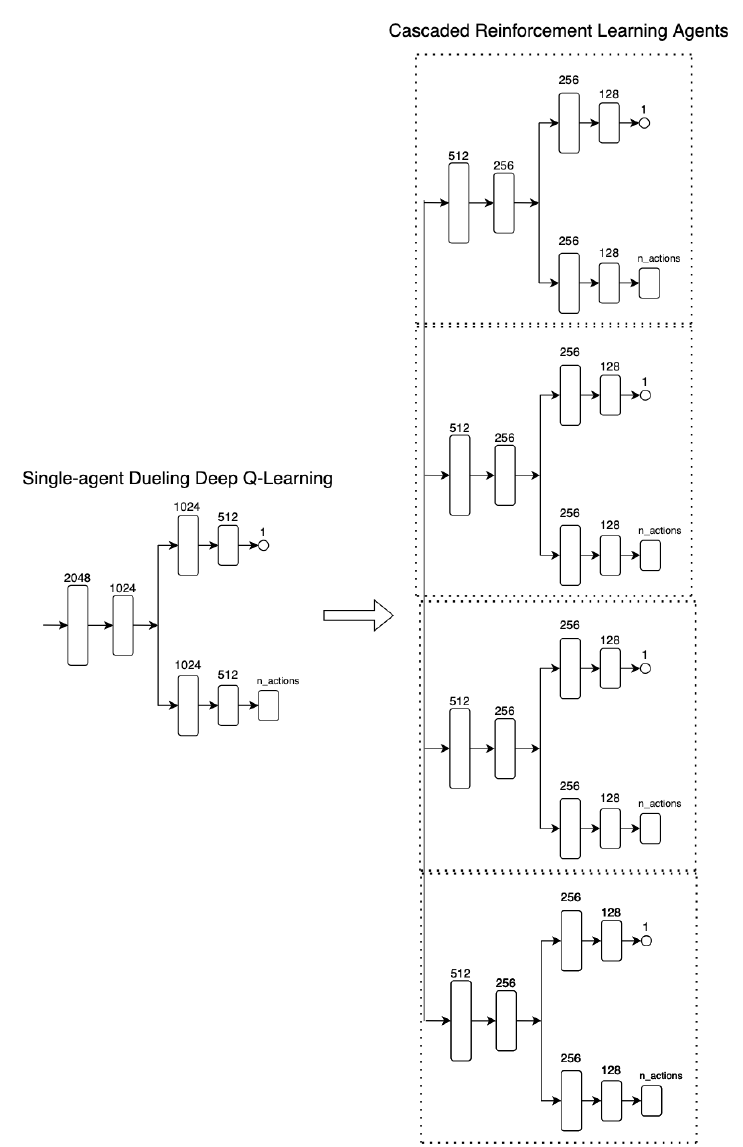
Figure A1. Neural network architectures comparison between the single-agent duelling deep Q- learning and the proposed cascaded reinforcement learning agents